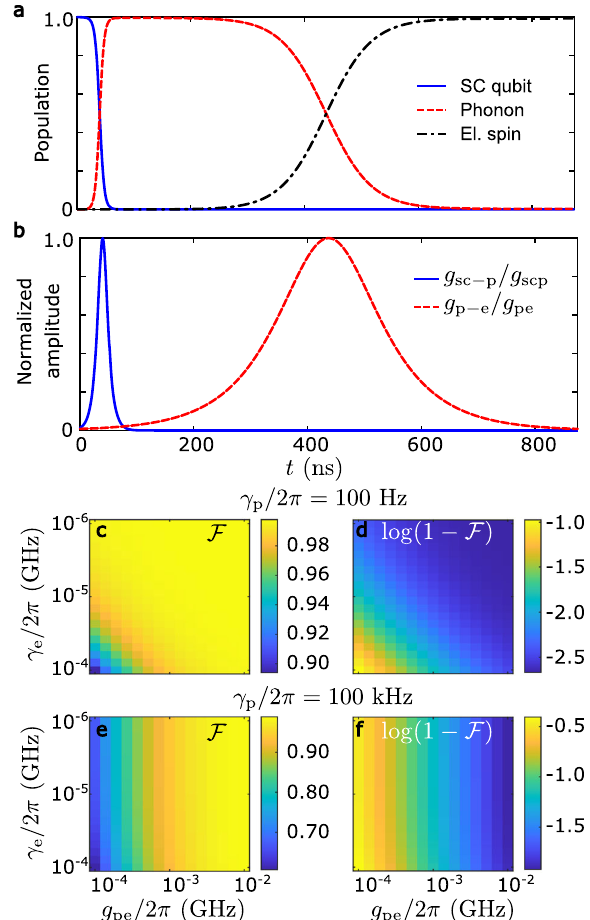
Fig. 4 State transfer from the SC qubit to the electron spin. The system begins in the excited state of the SC qubit, then evolves according to the master equation Eq. (2). The time-dependent populations of the SC qubit (full blue), the cavity phonon (red dashed), and the electron spin qubit (black dash-dotted) are plotted as a function of time in a . After initializing the system, we apply the series of pulses shown in b , as described in the text, and let the system evolve until the state is transferred to the electron spin. c , e The state-transfer fi delity F , and d , f log ð 1 (cid:1) FÞ . Both F , and log ð 1 (cid:1) FÞ are calculated as a function of the phonon-electron-spin coupling g pe and the electron-spin dephasing rate γ e . We maximize F for each pair of parameters [ γ e , g pe ] by adjusting the delays between the respective pulses applied to drive the system dynamics. We consider ( c , d ) γ p /(2 π ) = 10 − 7 GHz (corresponding to the mechanical quality factor Q ~ 10 7 ) and ( e , f ) γ p /(2 π ) = 10 − 4 GHz in the calculations.